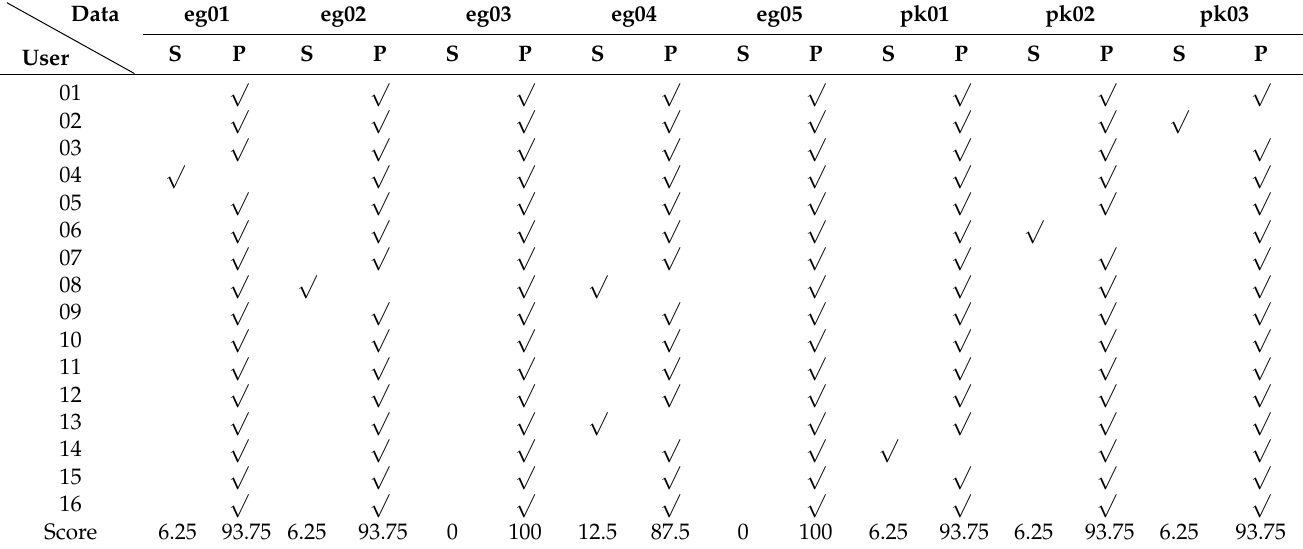
Table 4. The results for the user